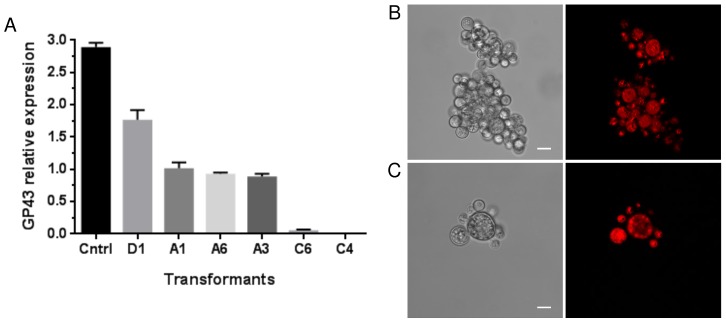
RNA interference of Pb18 GP43 gene expression triggered artificially with intron-containing dsRNA.(A). GP43 gene expression levels were investigated in six cAlf-GP43 transformants in relation to cAlfG-control by qRT-PCR after 8 months of subculturing in non-selective media. Results were normalized against the internal control L34. (B–C) Epifluorescence microscopy analysis of transformant C4 (C), in which the GP43 gene expression was nearly abolished, in comparison to cAlfG-control (B). Scale bar: 10 µm.